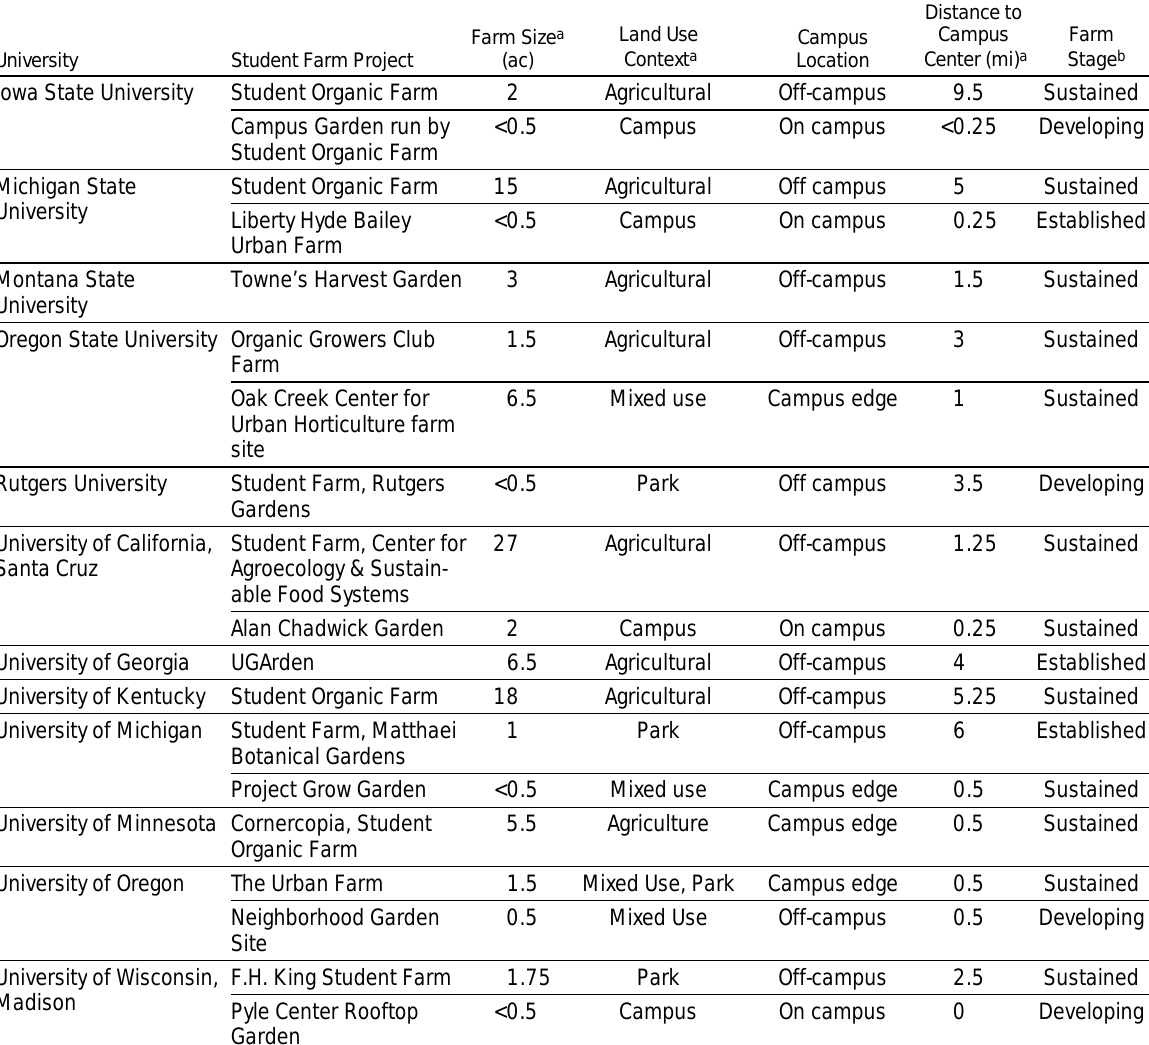
Table 1. Student Farm Sample